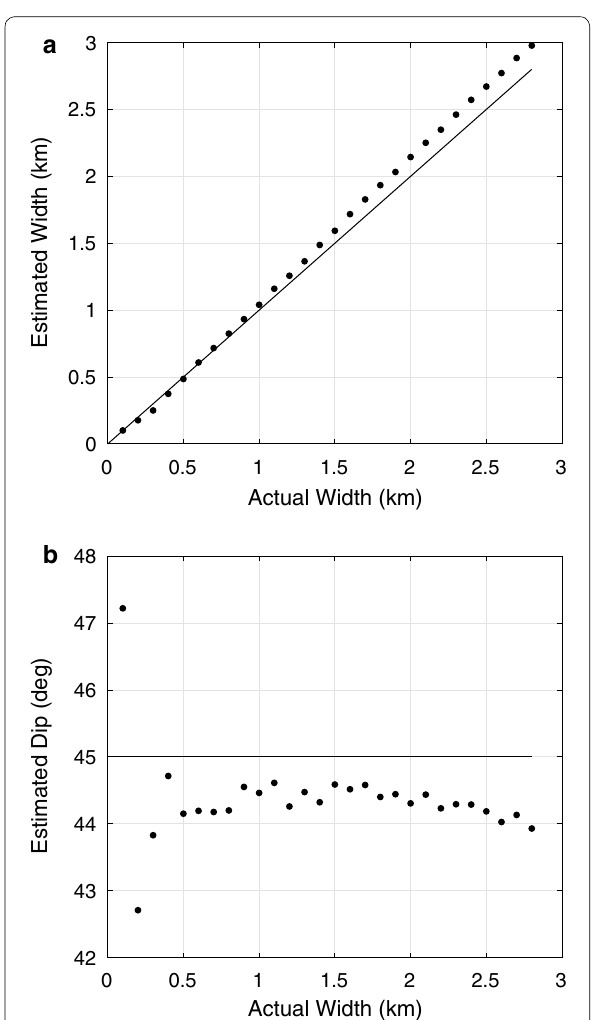
Fig. 13 Results of the synthetic test. a Estimated width of the fault as a function of the actual width. Solid line shows the relation of estimated width equals the actual width. One can convert to the √ 2 . b Estimated dip of the bottom depth by dividing the values by fault as a function of the actual width. Solid line shows the actual dip of